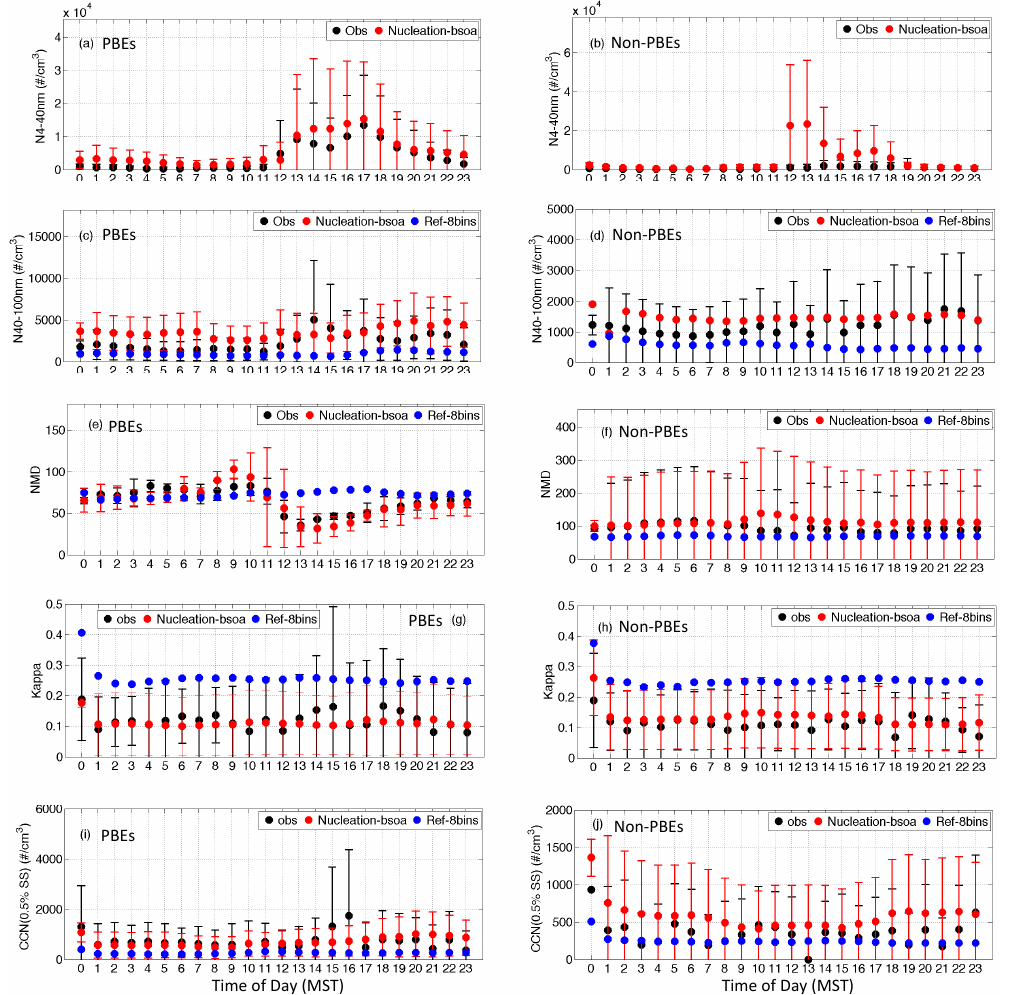
Figure 6. Comparison between measurements and simulations in diurnal profiles during PBE days (left column) and non-PBE days (right column). Black dots are observations, red dots are simulations from Nucleation-bsoa run, and blue dots are simulations from Ref-8bins run. Error bars show 1 σ variability. Plots show diurnal variations in (a, b) number concentrations of 4 to 40nm particles ( N 4 − 40nm ) and (c, d) of 40 to 100nm particles ( N 40 − 100nm ) , diurnal profiles of (e, f) the number mean diameters (NMD), (g, h) kappa values, and (i, j) number concentrations of CCN at 0.5% SS.